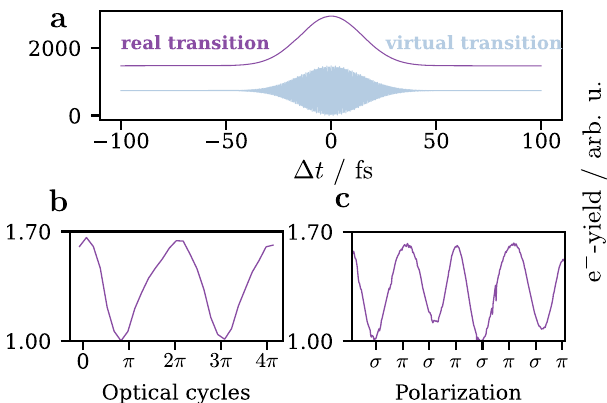
Fig. 4 Phase-dependent effective light polarization on polycrystalline silver. a Simulated photoemission yield for an isotropic angle distribution. b Zoom into two optical cycles around time zero from Fig. 1b, normalized to the minimum signal. c Normalized photoemission yield for different polarizations impinging on